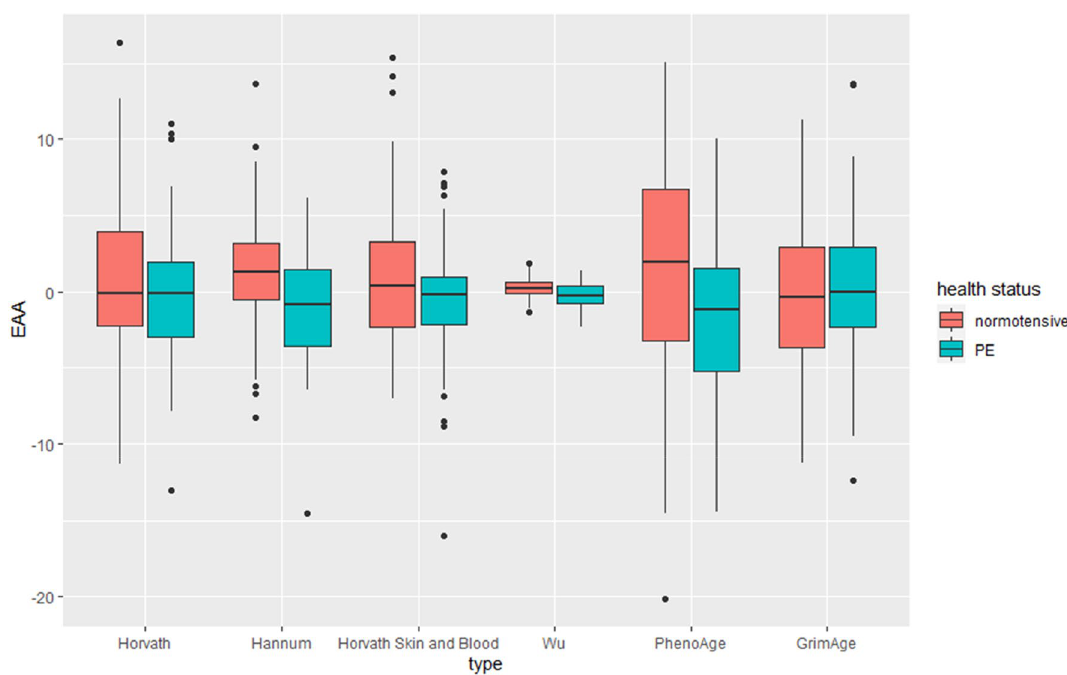
Figure 4. Epigenetic age acceleration (EAA), which represents the residuals from a linear regression model of chronological age with six different DNAm Age